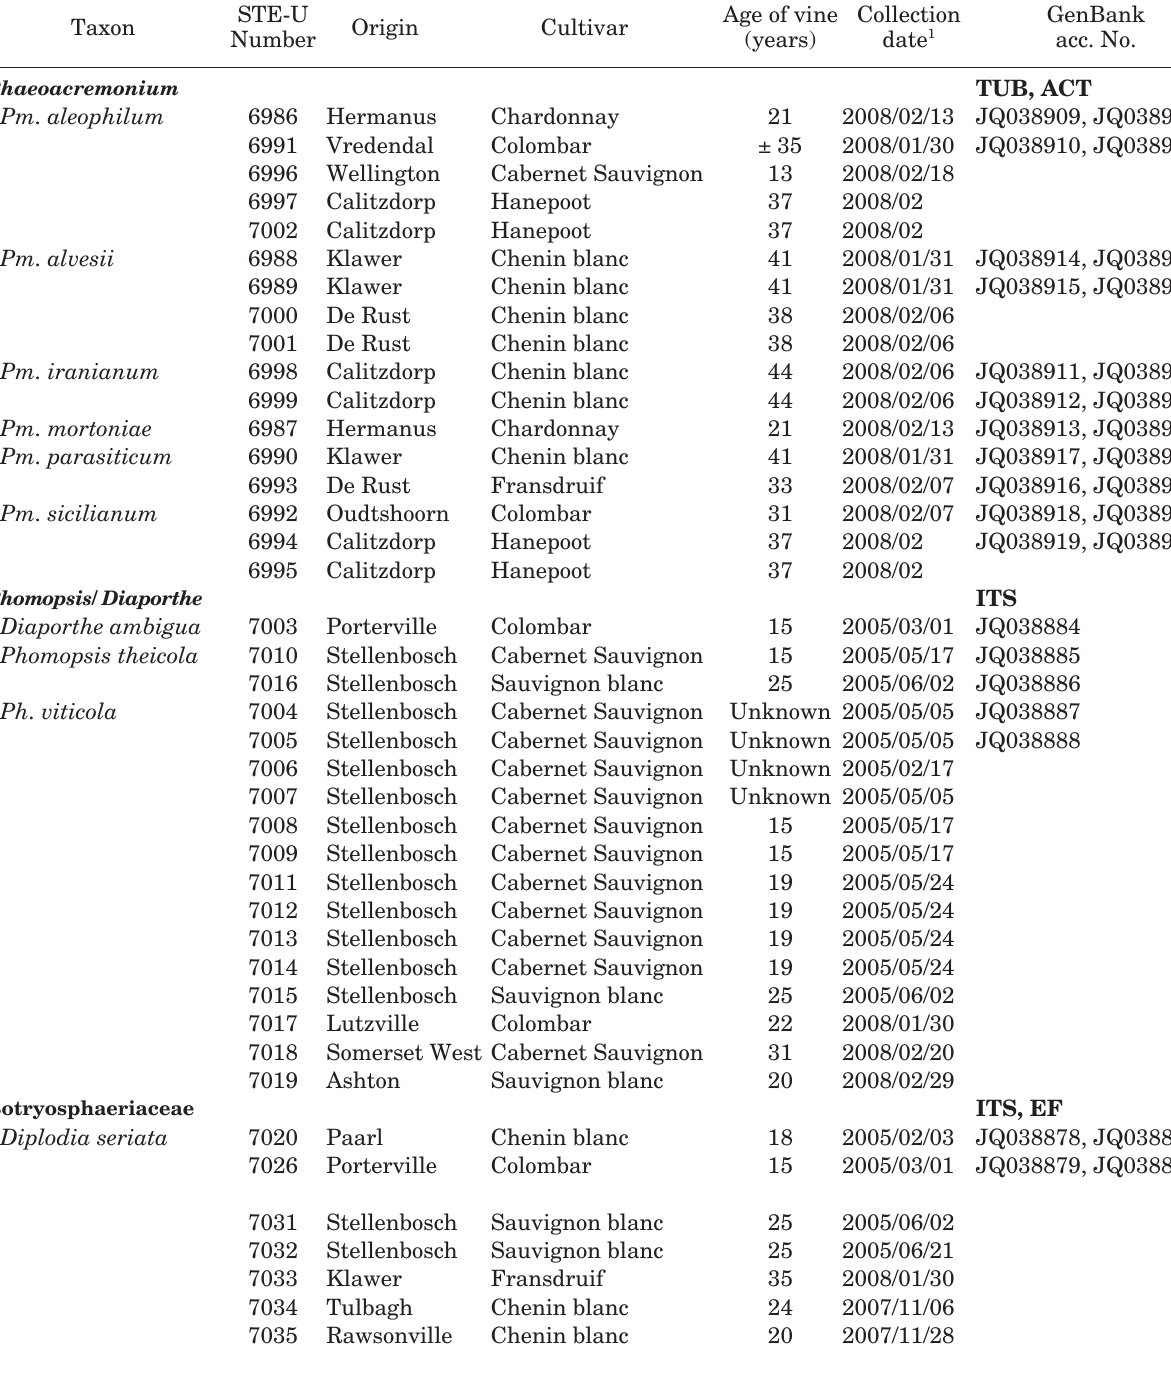
Table 1. Details of origin, host cultivars and ages, collection dates and GenBank accession numbers for Phaeoacre- monium, Phomopsis, Botryosphaeriaceae, Eutypa and basidiomycete isolates obtained from esca affected grapevines ( Vitis vinifera ) in South